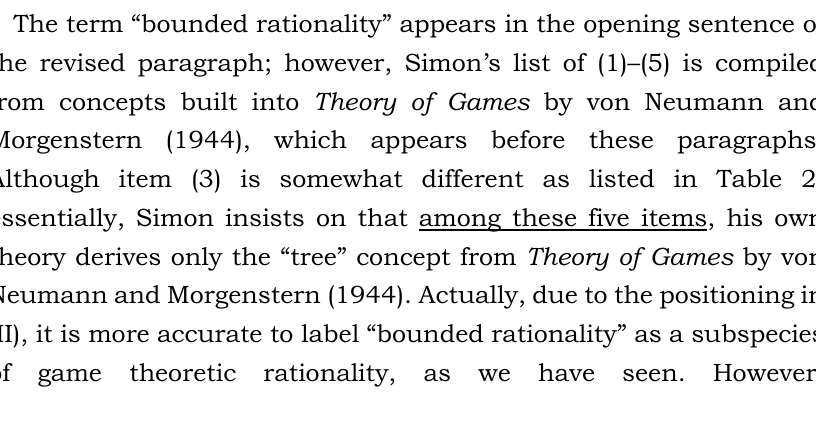
Table 2. Concepts built into Theory of Games of von Neumann and Morgenstern incorporated by Administrative Behavior of Simon Concepts built into Theory of Games of von Neumann and Morgenstern